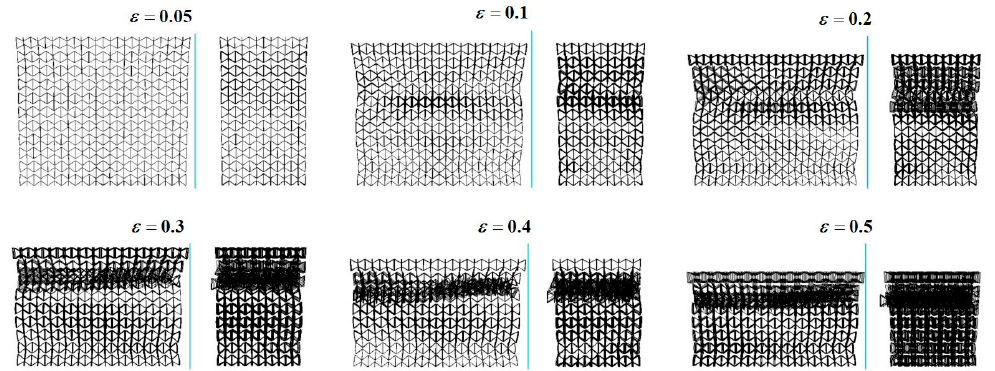
Figure 4. Deformation process of the 3D re-entrant auxetic structure under the crushing velocity 𝑣 (cid:3030) = v c = 5 5m/s.